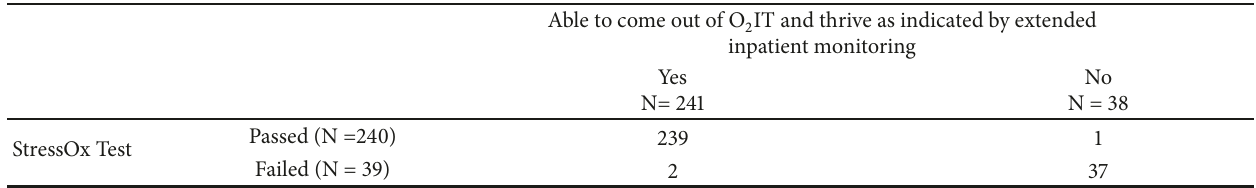
Table 2: Ability of StressOx test to determine need for oxygen inhalation therapy (O 2 IT). Able to come out of O 2 IT and thrive as indicated by